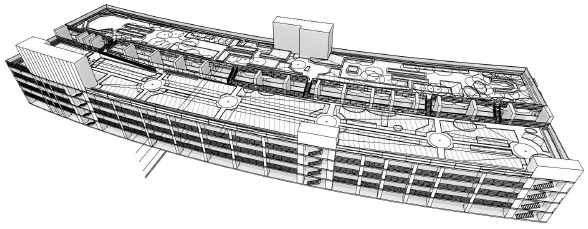
Figure 15. Placeholders in a landscape plan of a rooftop garden.